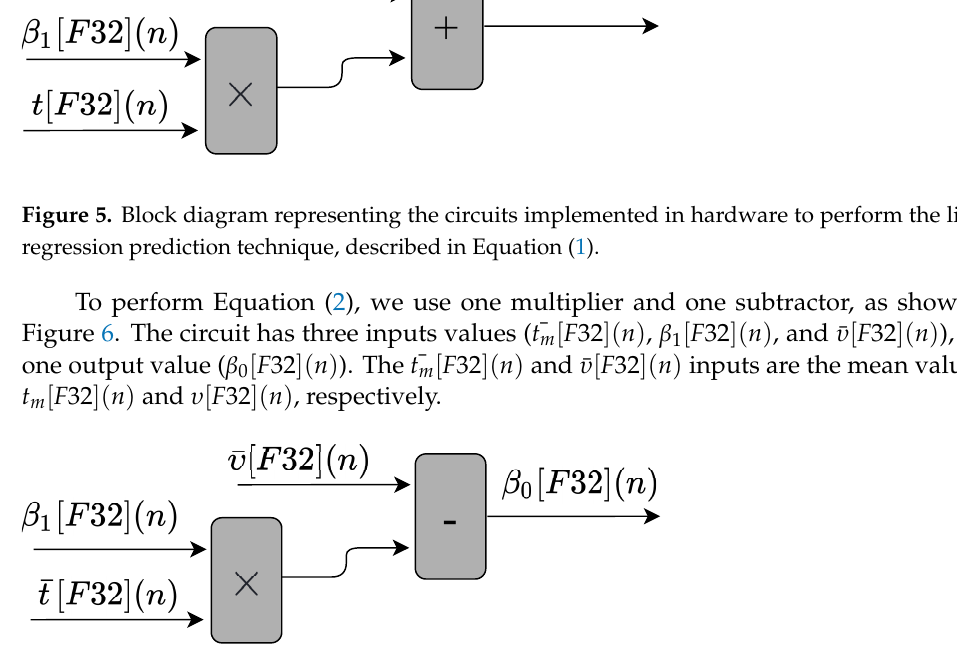
Figure 6. Block diagram representing the circuits implemented in hardware to obtain the β 0 variable used in the linear regression prediction technique.